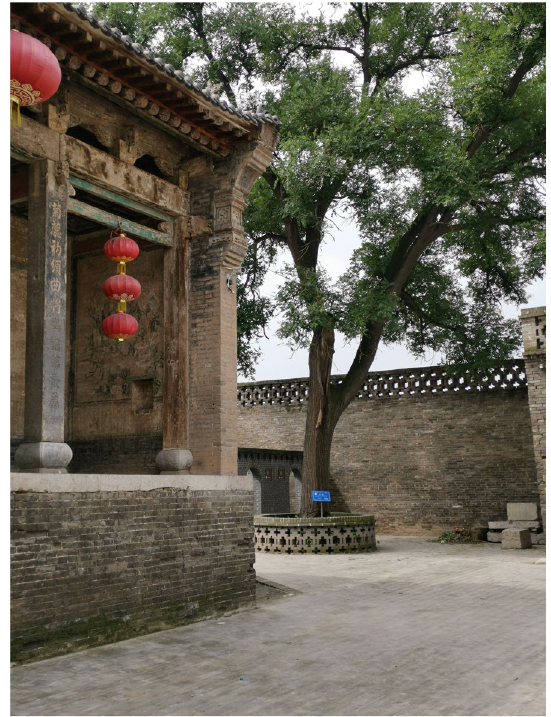
Fig. 24 The status of the stage square after the 2021 flood (Source: the